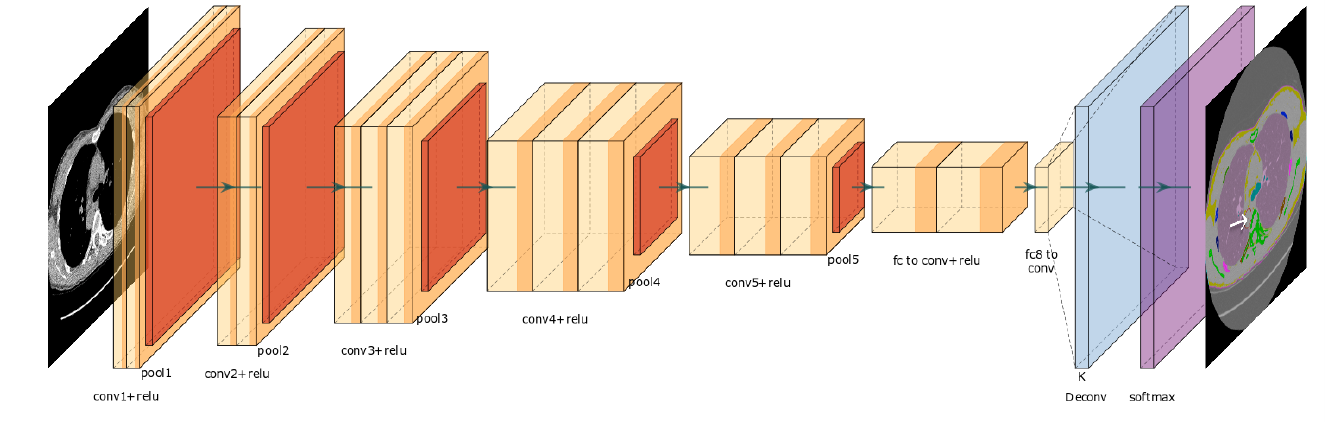
Fig. 2. Volumetric scheme of FCN for anatomy segmentation in whole-body CT